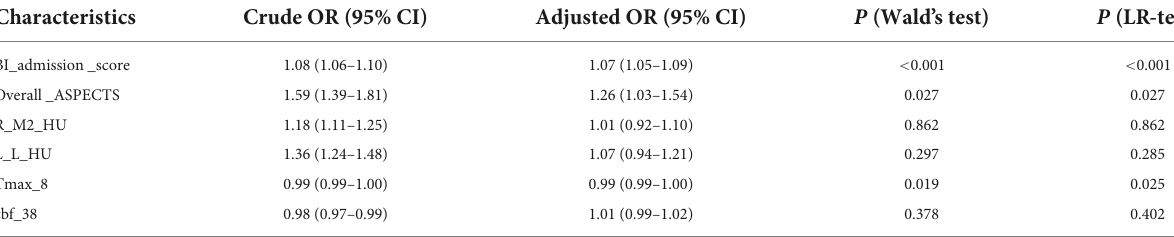
TABLE 2 Multivariable logistic analysis of clinical and imaging variables with clinical outcome (BI > 60 vs. BI ≤ 60).